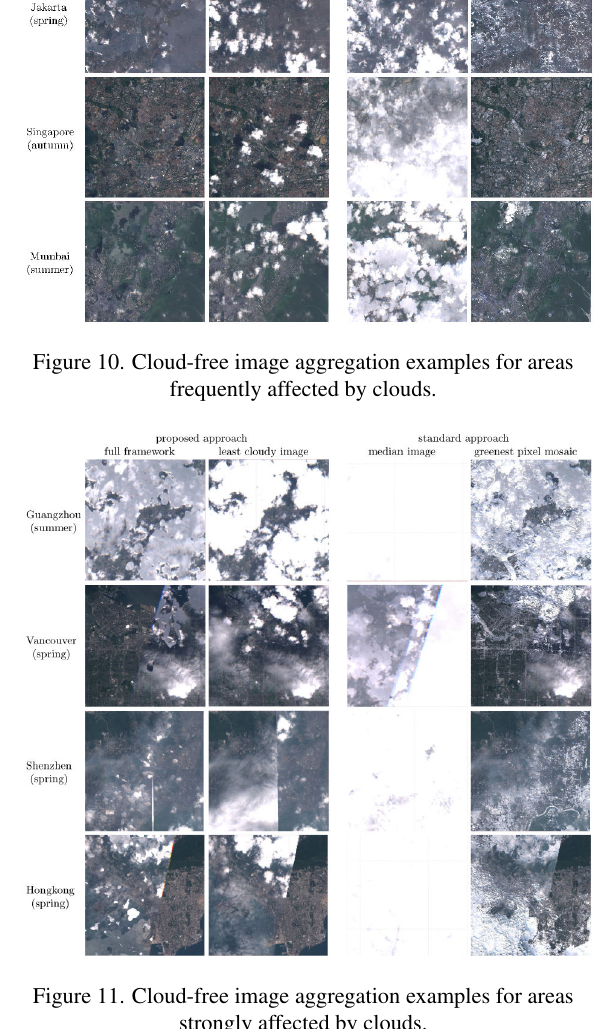
Figure 11. Cloud-free image aggregation examples for areas strongly affected by clouds.